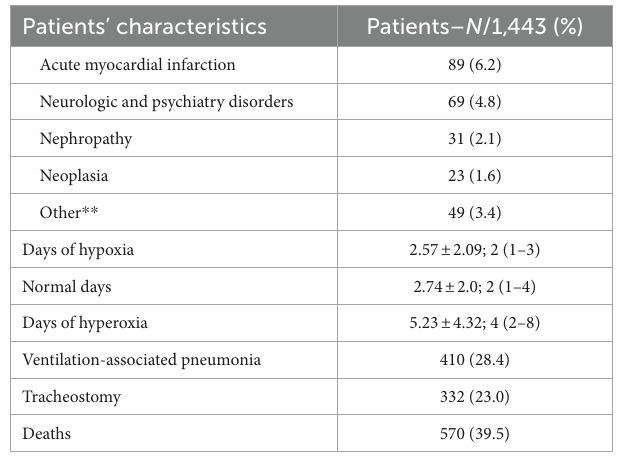
* Supplementary Table S1; ** Supplementary Table